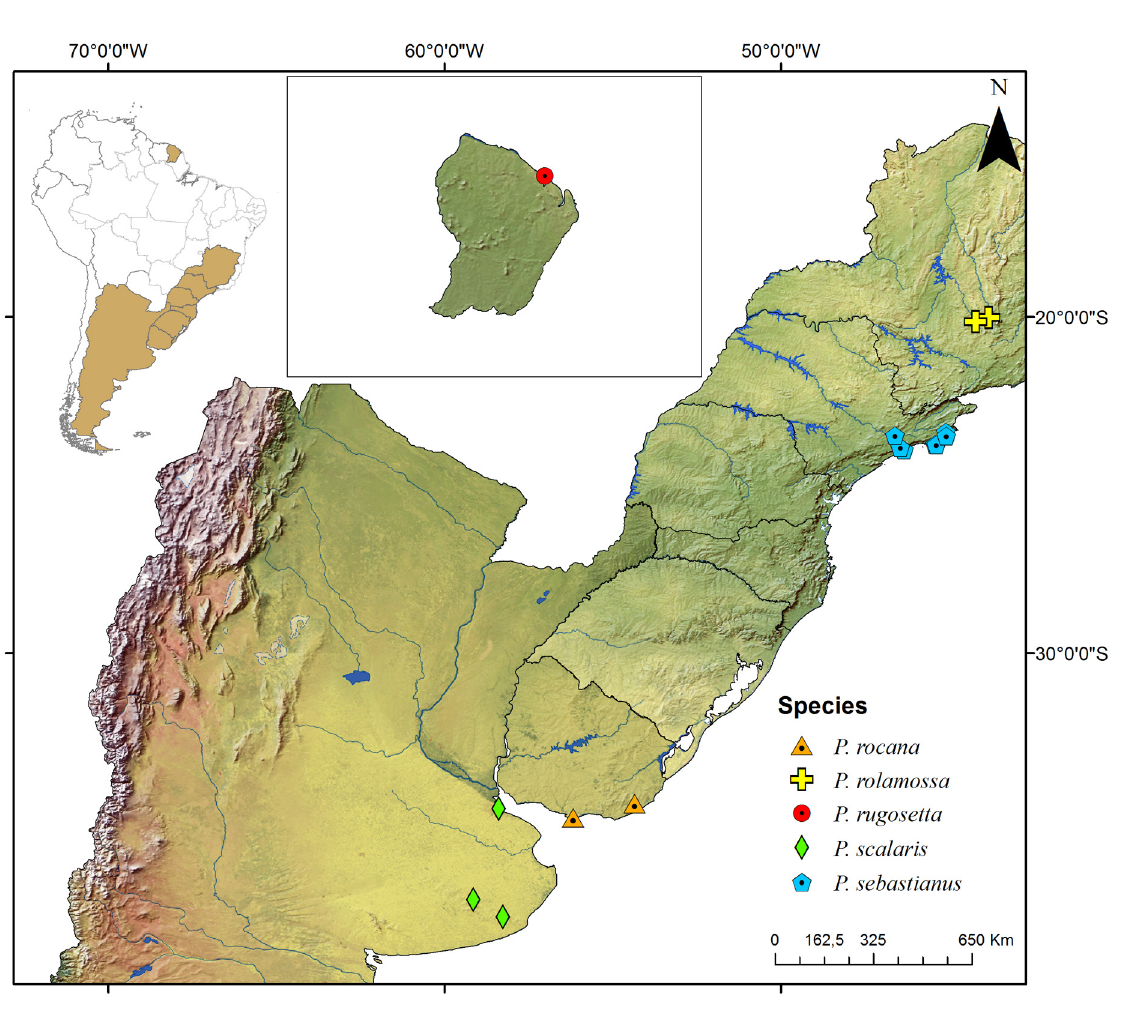
Fig. 187. Distribution map of the species Pseudonannolene rocana Silvestri, 1902, P. rolamossa Iniesta & Ferreira, 2013, P. rugosetta Silvestri, 1897, P. scalaris Brölemann, 1902, and P. sebastianus Brölemann,